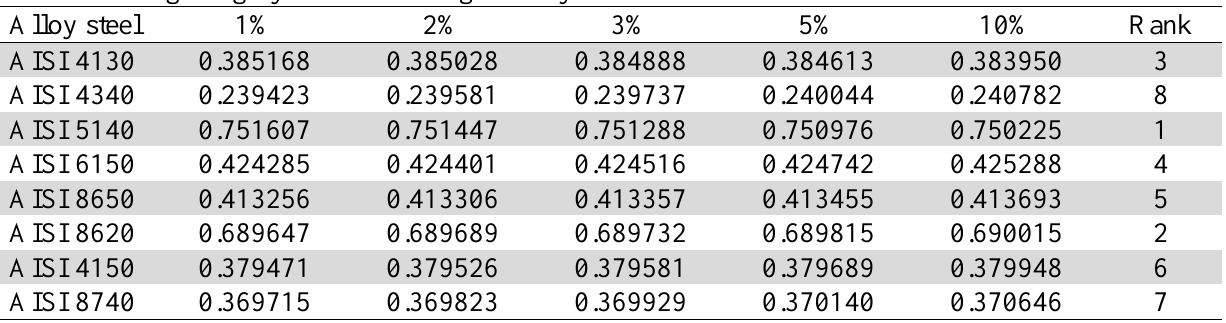
Effect of change in greyness on ranking of alloy steels Alloy